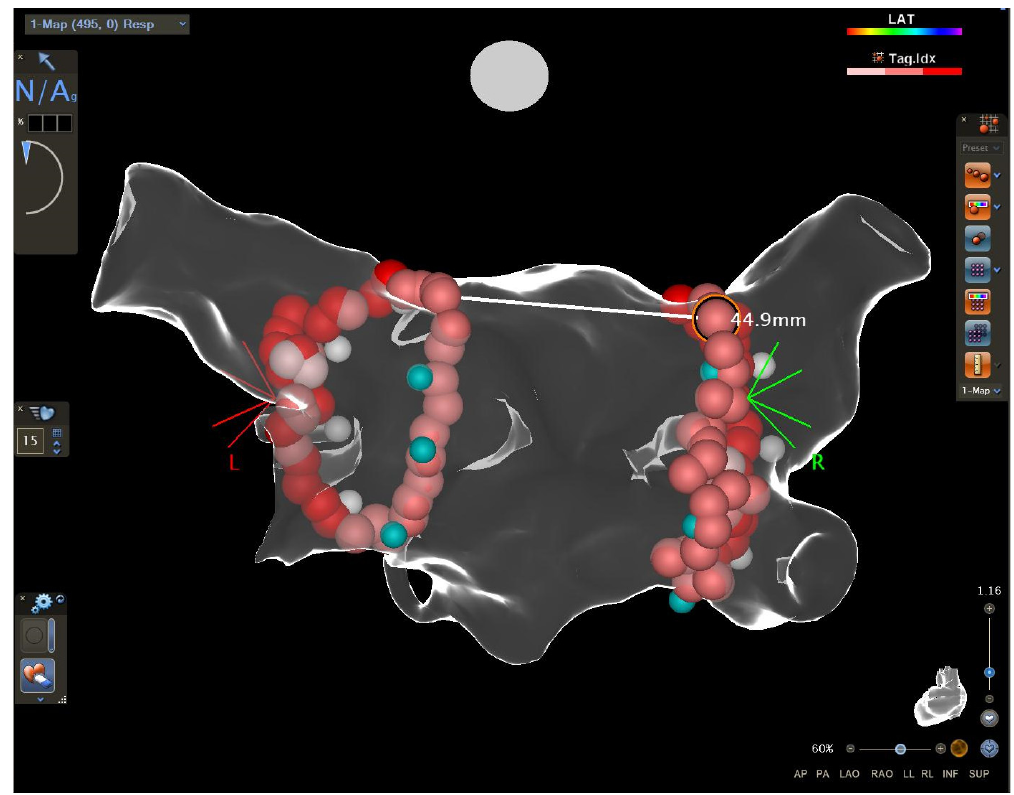
Figure 1. The measurement of the upper distance between the uppermost points.